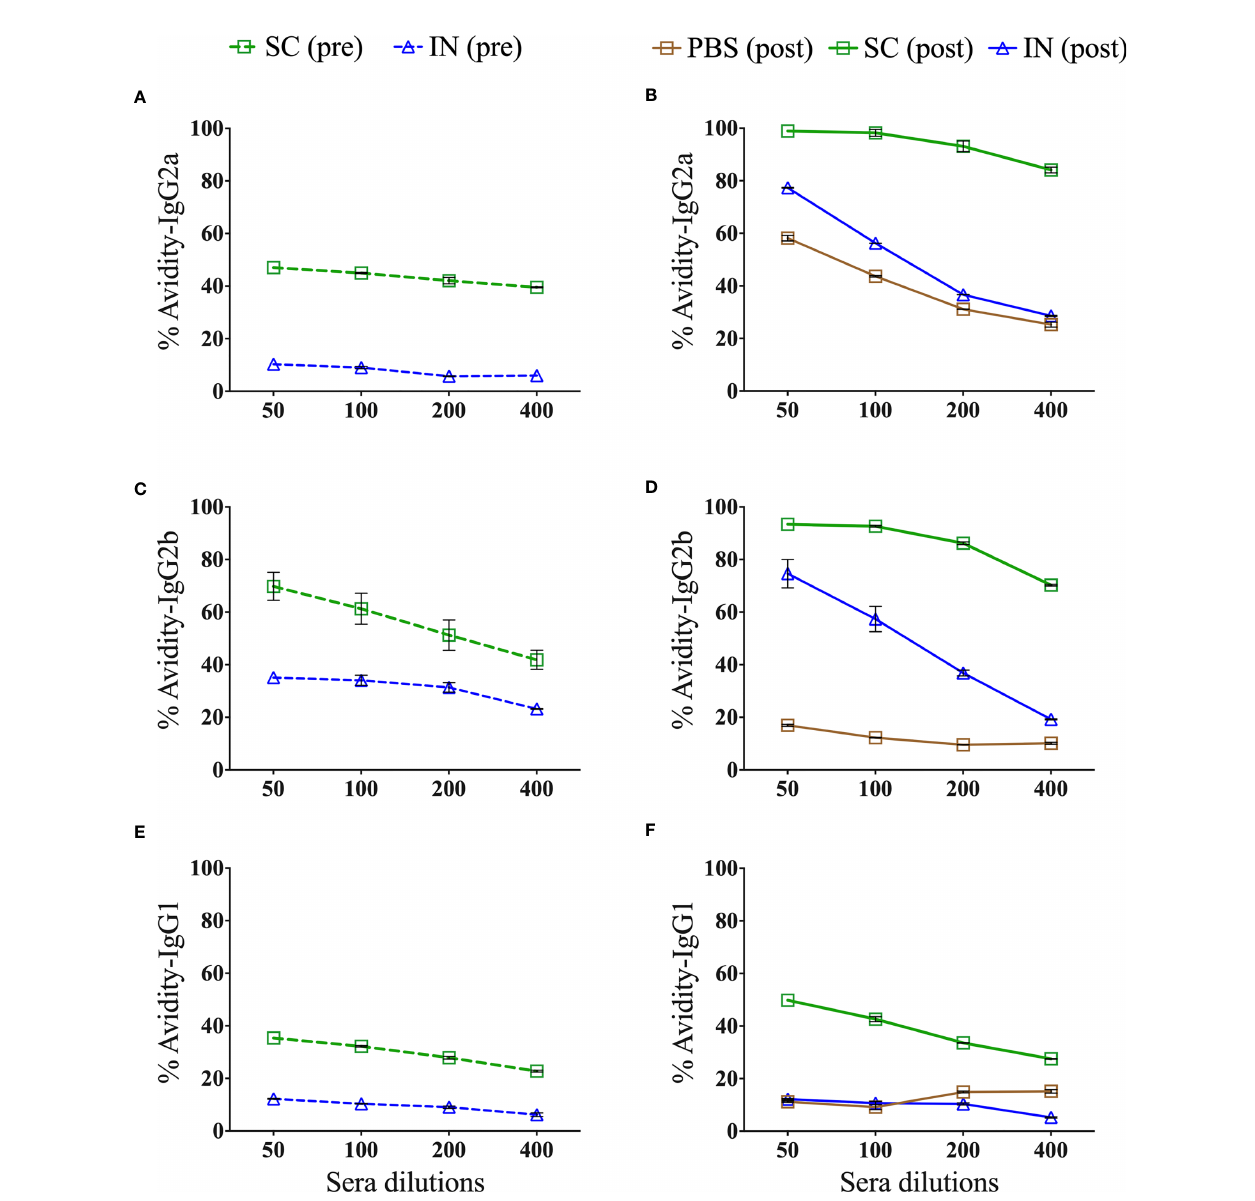
FIGURE 7 | Avidity index of antigen-speci fi c serum IgG2a, IgG2b and IgG1 isotype antibodies. Groups of mice were immunized three times at two-week intervals with PBS or PLGA-rMOMP via the SC or IN routes. Each mouse was challenge and re-challenge intravaginally with 1×10 5 IFU of C. muridarum. Avidity-ELISAs were conducted using pooled sera from immunized (pre) and immunized-re-challenge (post) mice to determine the avidity index (%) for rMOMP-speci fi c IgG2a (A) , IgG2b (C) , IgG1 (E) antibodies (pre), and IgG2a (B) , IgG2b (D) , IgG1 (F) antibodies (post). Each data point represents the mean ± SD of triplicates from each sample. The PBS control mice (pre) did not produce antigen-speci fi c antibodies to calculate the avidity index (A, C, E)